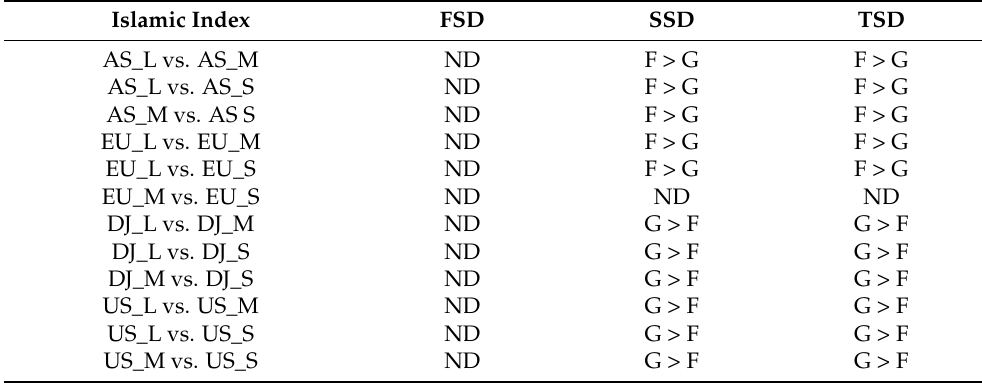
Table 6. Descending Stochastic dominance (DSD) results of Davidson and Duclos test: sub-period 1